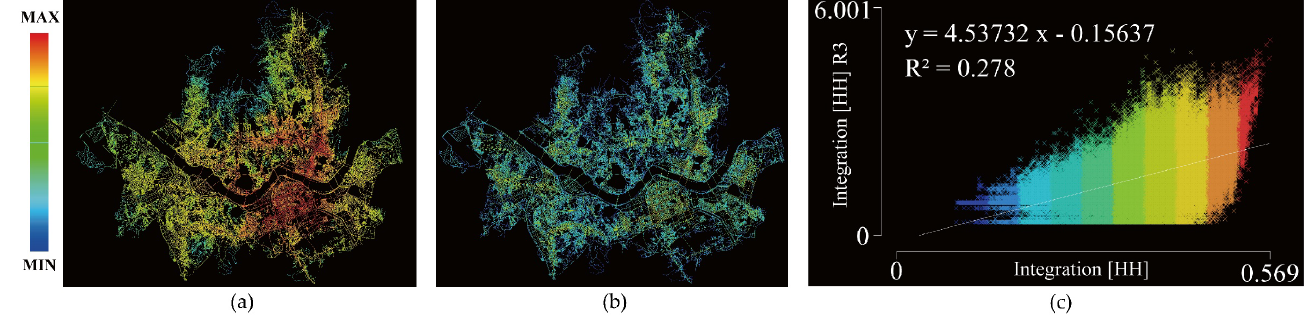
Figure 6. Urban hierarchy graph − Seoul: ( a ) Global integration graph; ( b ) Local integration graph; ( c ) Intelligibility.